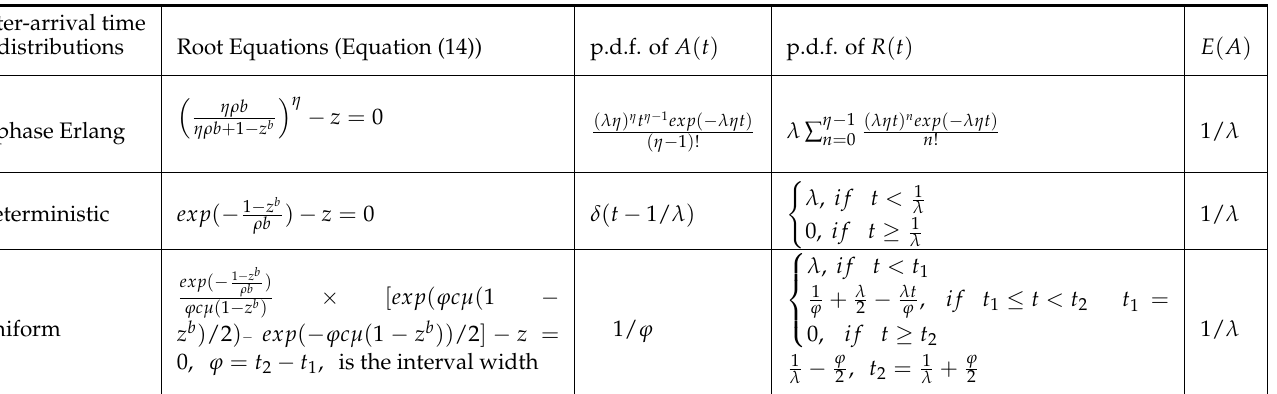
Table 5. Root Equations, p.d.f.s of A ( t ) , R ( t ) , and mean value of of A ( t ) for E η /M a , b / c , D/M a , b / c and U/M a , b / c